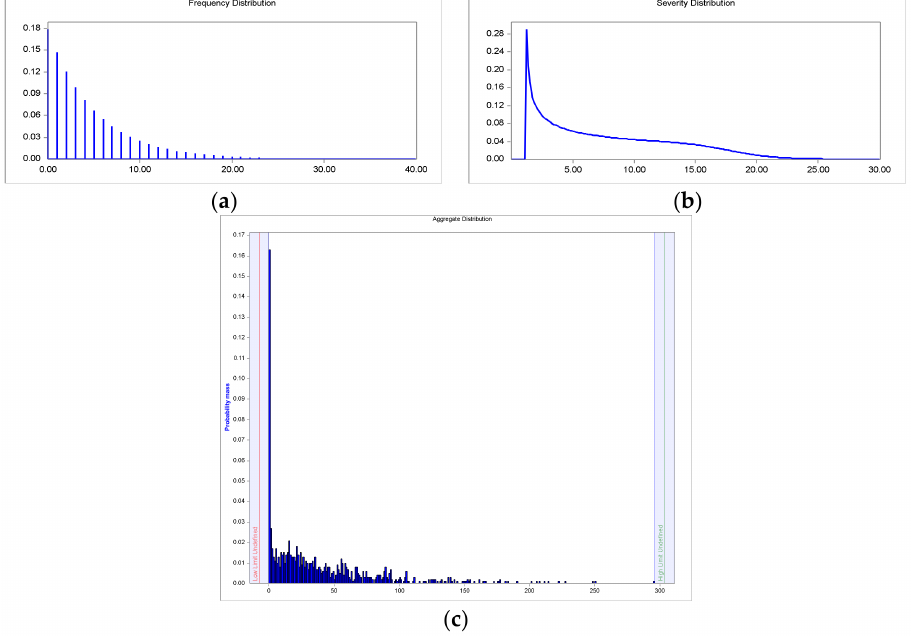
Figure 6. Clinical-VaR: ( a ) Frequency histogram of the geometric distribution; ( b ) Probability density function (PDF) of the Burr distribution; ( c ) Loss distribution approach (LDA).